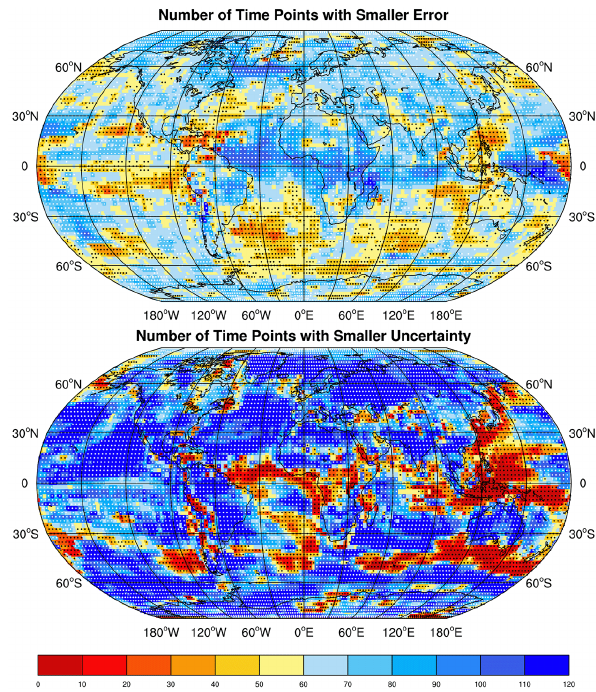
Figure 7. The number of time points in which the EGA forecaster performs better. The upper panel shows the spatial distribution of the number of time points in which the absolute error of the EGA forecaster is smaller than that of the climatology. The lower panel shows the spatial distribution of the number of time points in which the uncertainty of the EGA-weighted ensemble is smaller than that of the equally weighted ensemble. White circles represent signifi- cant improvement by the EGA forecaster and black circles repre- sent its significantly poorer performance. Both quantities show bet- ter performance of the EGA forecaster over most of the globe.